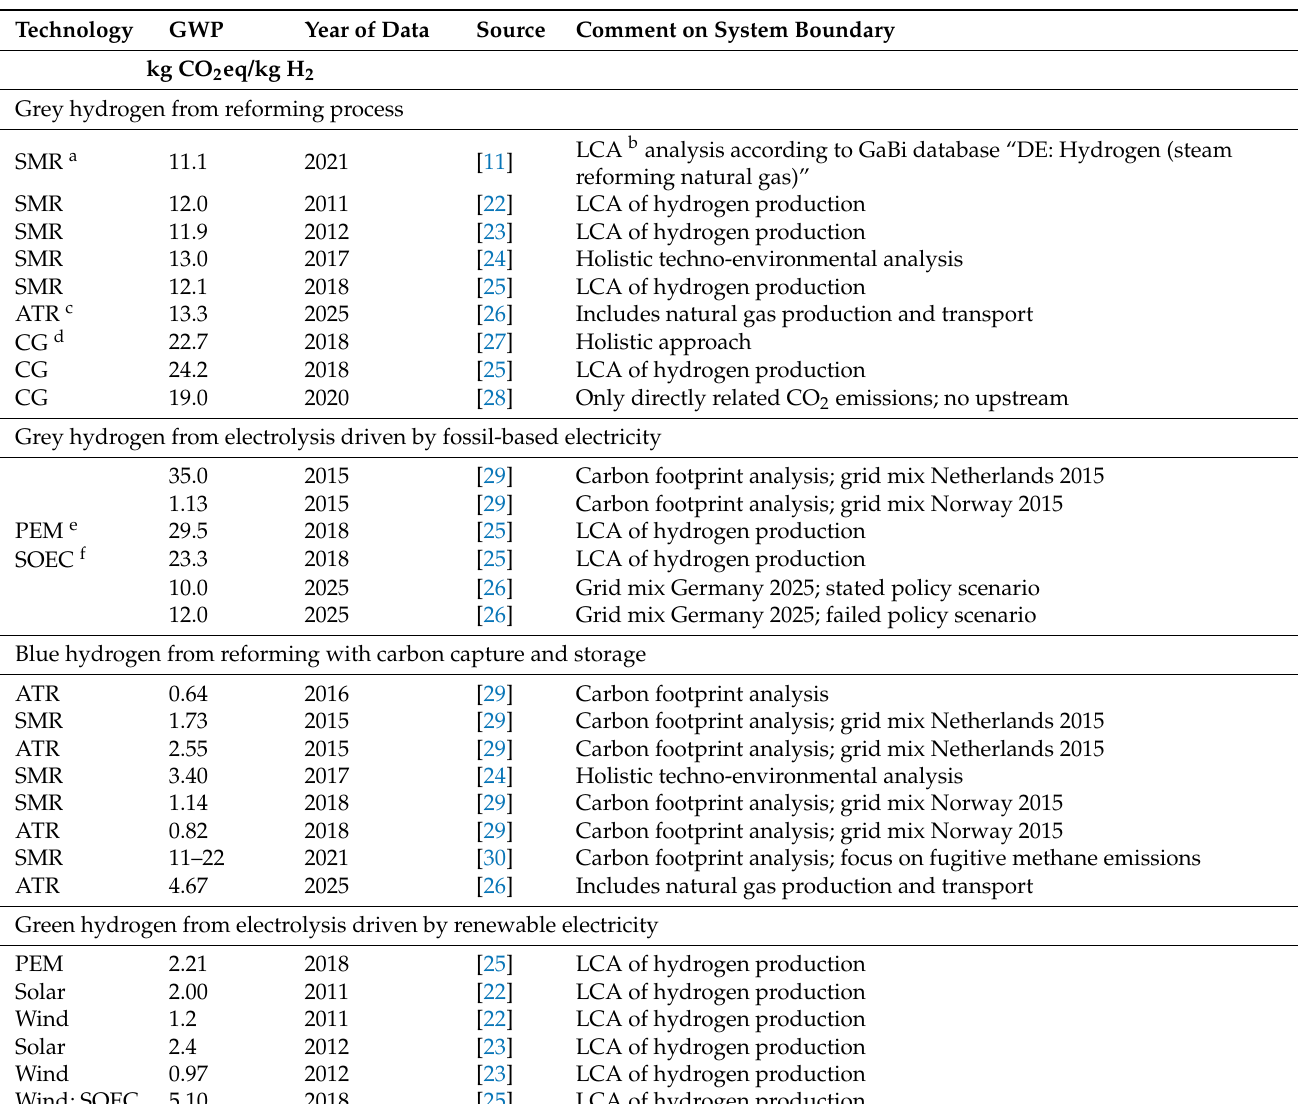
Table 1. Global warming potential (GWP) of different hydrogen production